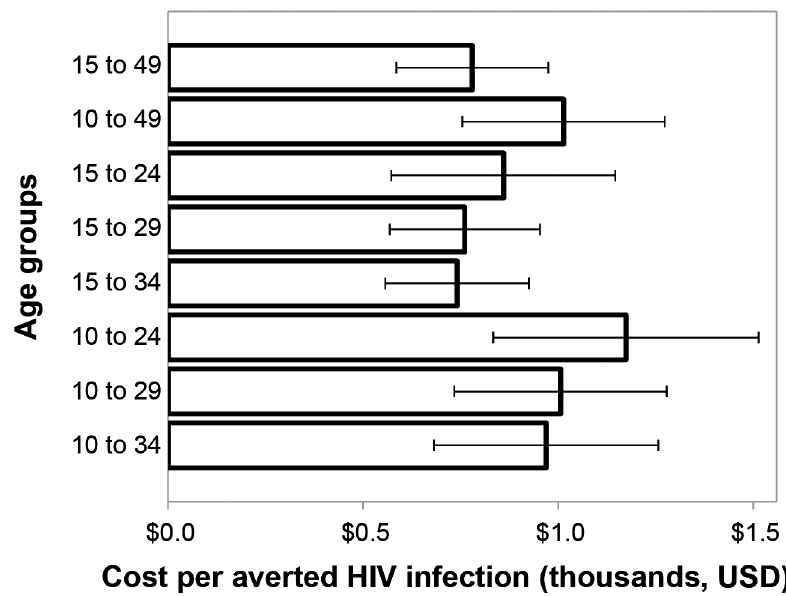
Fig 3. Cost per HIV infection averted in scenarios scaling up VMMC among different client age groups. The period for measuring HIV infections averted was 15 years, 2014 – 2028, inclusive. Error bars represent uncertainty